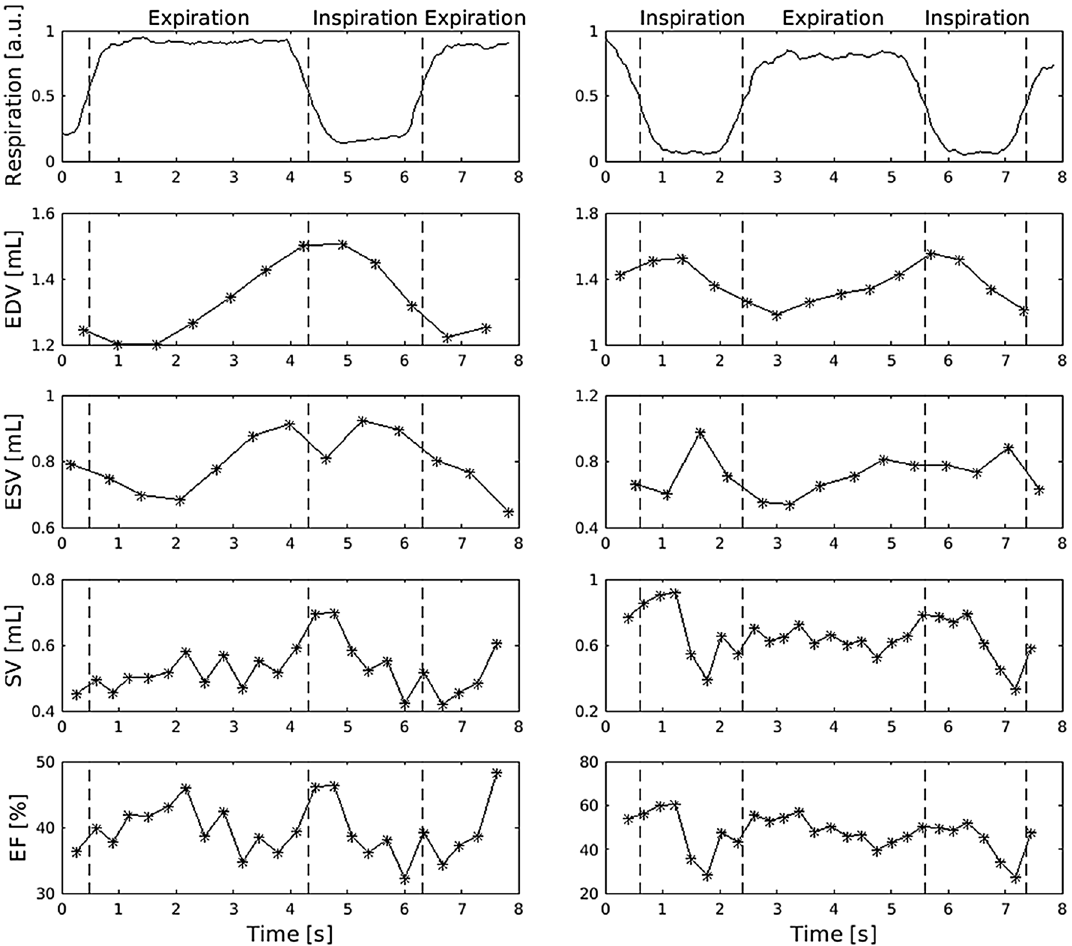
Figure 3. Function-time curve over consecutive heartbeats. The signal-time curve of the respiratory signal (normalized by mean of maximum for expiration and minimum for inspiration) and the extracted functional parameter (EDV, ESV, SV and EF) of a Real-Time experiment over consecutive cardiac cycles were exemplarily plotted for a mid-ventricular slice of two different animals. Both EDV and ESV systematically show a periodical behavior leading to highest volumes in inspiration and lowest at expiration. Although EDV and ESV show fluctuations up to 30% in each cardiac cycle the estimated EF has only a minor fluctuation up to 10%. EDV: End-Diastolic Volume; ESV: End-Systolic Volume; SV: Stroke Volume; EF: Ejection